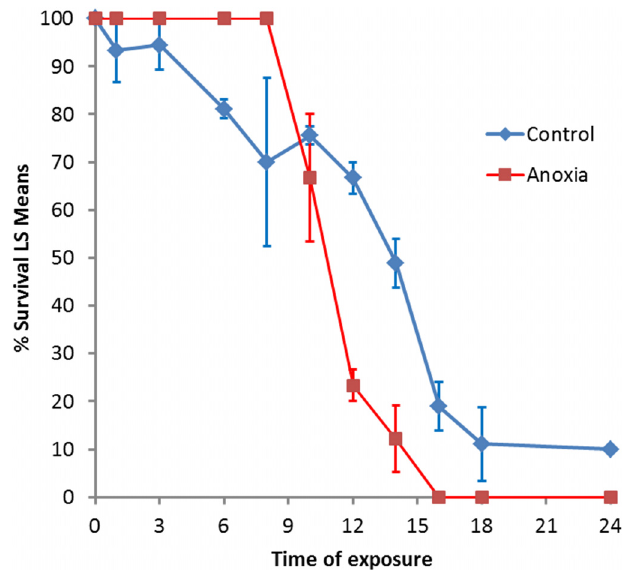
Figure 1. Survival of head lice after anoxia exposure compared with control lice maintained at ambient temperature.